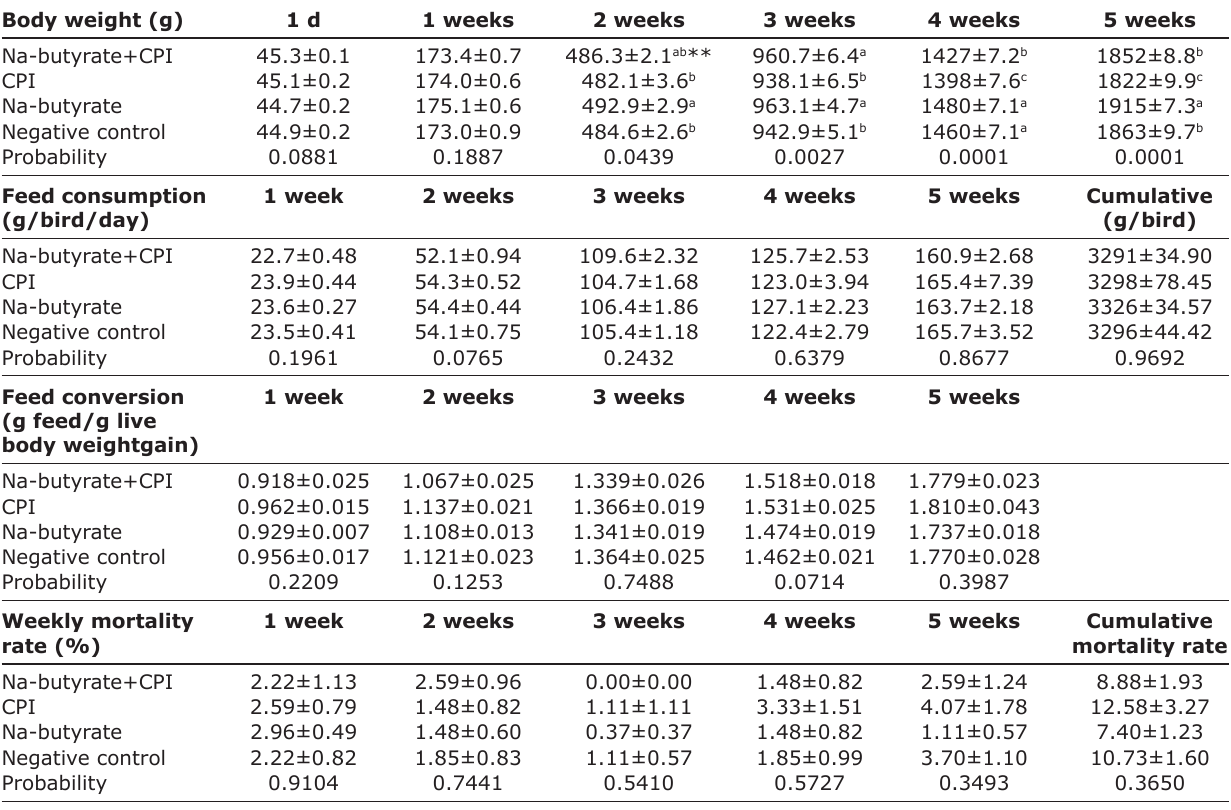
Table-2: Effect of Na-butyrate feed supplementation on performance and mortality of CPI and non-infected broilers. Body weight (g) 1